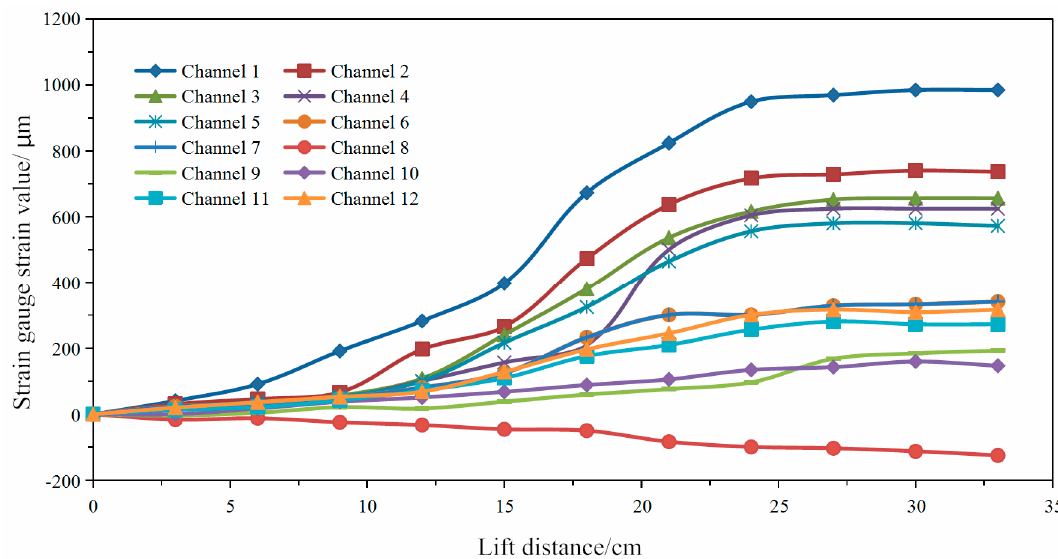
Figure 6. Stress relief curve of tested point 1. Table 2. Summary of rock mechanics parameters.